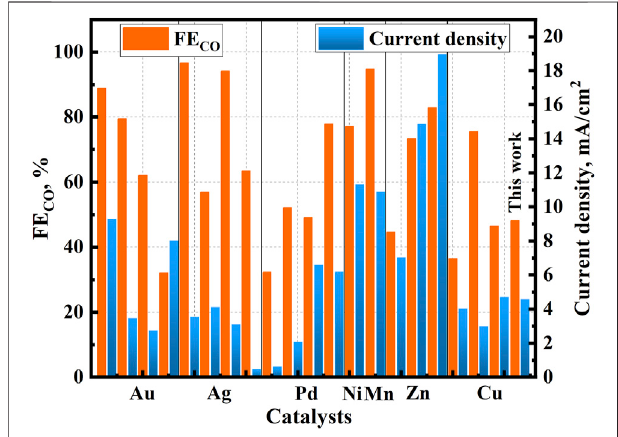
Frontiers in Energy Research |